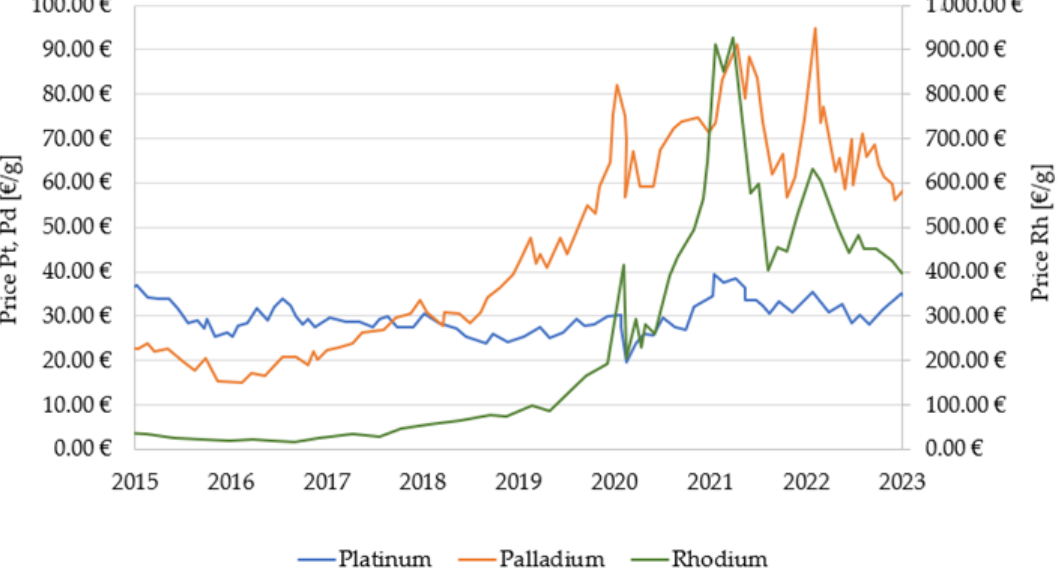
Figure 1. Trend in PGM prices from 2015 to 2023 [4].